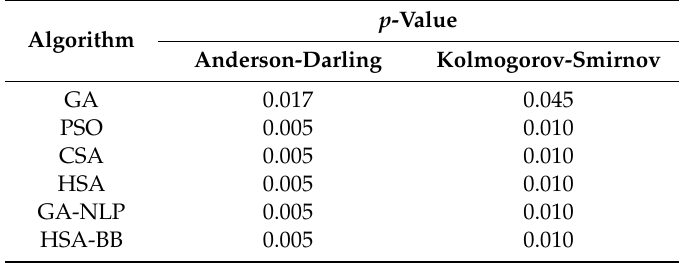
Table 13. Comparative results of normality tests of all the algorithms.